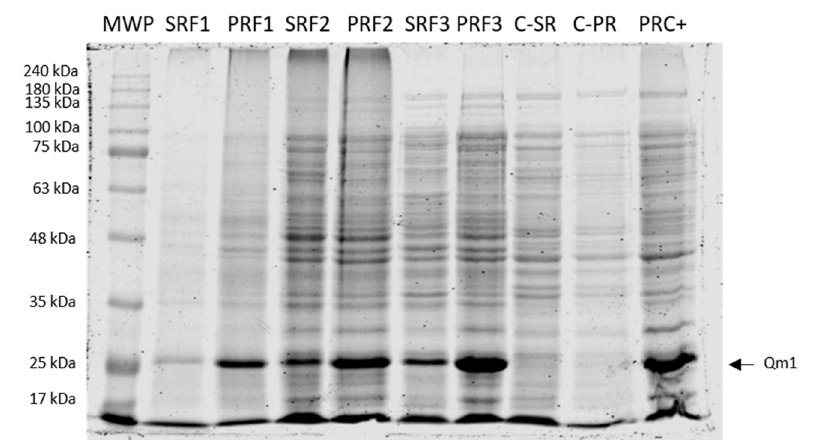
Figure 8. SDS-PAGE of the Qm1 expression in fermentation. SDS-PAGE with Coomassie blue staining under reducing conditions after 6 h of induction. MWP: molecular weight pattern; SRF1, SRF2, and SRF3: rupture supernatants from each of the three fermentations of the Qm1 with SHuffle ® T7 Express clone; PRF1, PRF2, and PRF3: the pellet of rupture from each of the three fermentations of Qm1 SHuffle ® T7 Express clone; C-SR and C-PR: the rupture supernatants and pellet of rupture from the fermentation negative control sample. PRC +: the previous sample obtained positive detected by Western blot with an anti-his antibody. We used 20 µL per sample . Table 1. The performance parameters of three fermentations of Qm1 expression in SHuffle ® T7 Express E. coli strain after 8 h of culture .